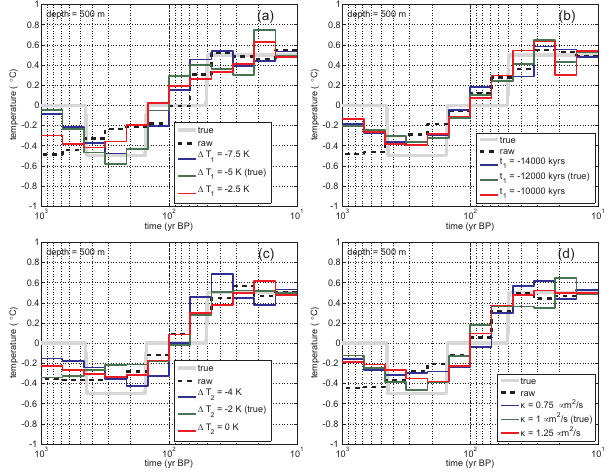
Fig. 5. Sensitivity of inversion results to different parameters used for the calculation of BTPs used for correction. The inverted BTP had a length of 500m, and were perturbed with normally dis- tributed noise characterized by zero mean and a standard devia- tion ˆ σ =0.05K. Data were corrected with different paleotempera- ture scenarios. (a) the amplitude of LGM, T 1 ; (b) the correspond- ing step time t 1 ; (c) the preglacial long term mean T 2 ; (d) the rock . A regularization parameter of 0.12 was thermal diffusivity κ = λ ρc used for all